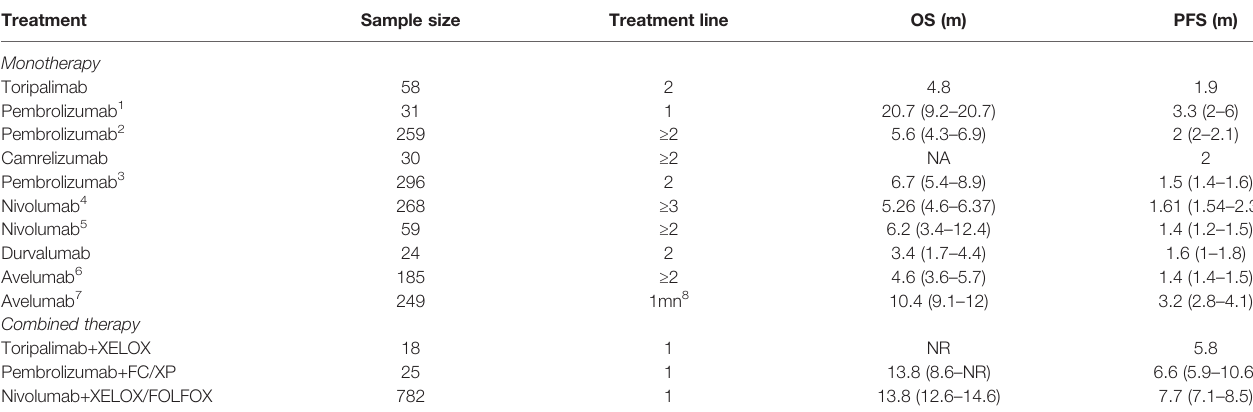
TABLE 2 | Survival information immunotherapy in allover population.